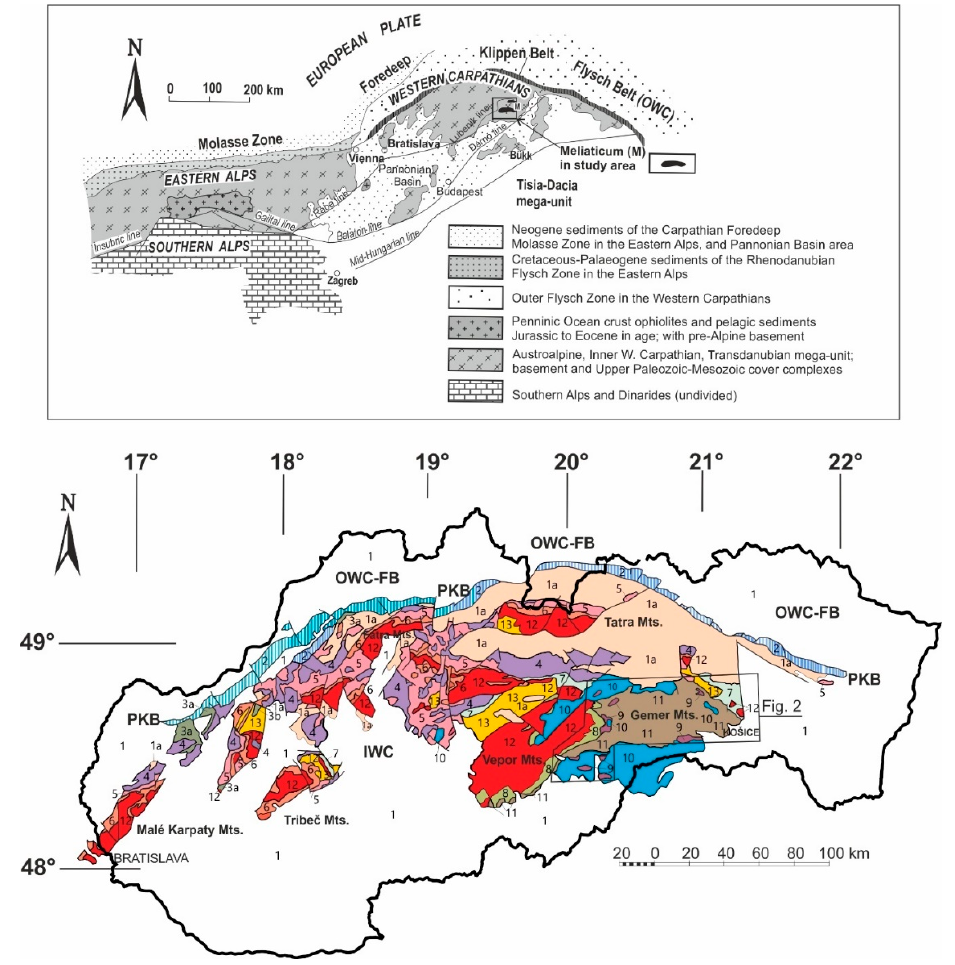
Figure 1. Position of the Western Carpathians and the schematic tectonic map of the Inner Western Carpathians (IWC, modified from [25]). 1—Quaternary and Cenozoic deposits undivided; Outer Western Carpathians Flysch Belt (OWC-FB); 1a—Paleogene deposits of the IWC; 2—Pieniny Klippen Belt (PKB); 3a—Upper Cretaceous to Eocene Gosau-type sediments; 3b—Upper Cretaceous Infratatric Succession; 4—Hronic nappes; 5—Fatric nappes; 6—Tatric cover; 7—North-Veporic cover; 8—South-Veporic cover; 9—Meliatic nappes; 10—Silicic nappes (including Turnaicum); 11—Gemeric Paleozoic basement (Variscan Lower Unit) and cover; 12—Variscan Upper Unit; and 13—Variscan Middle Unit.